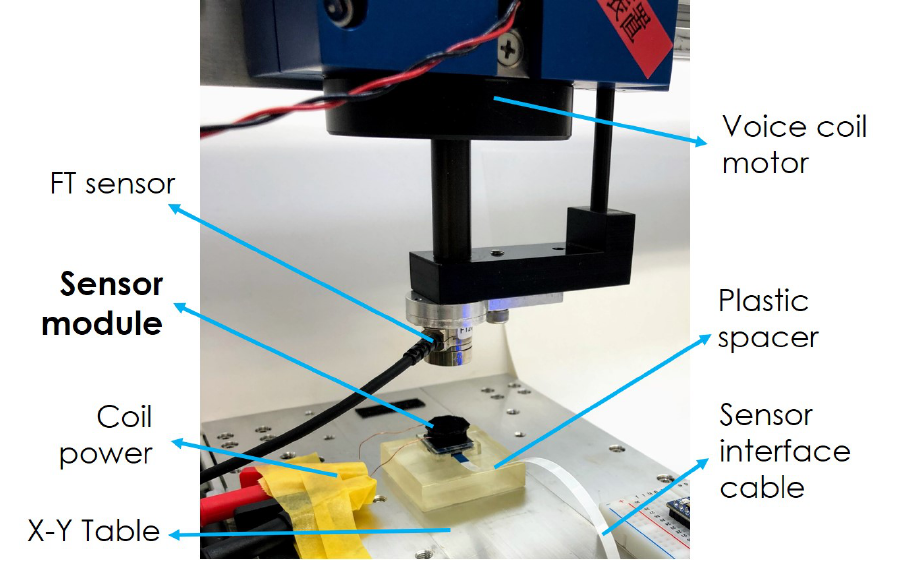
Figure 8. Force experiments